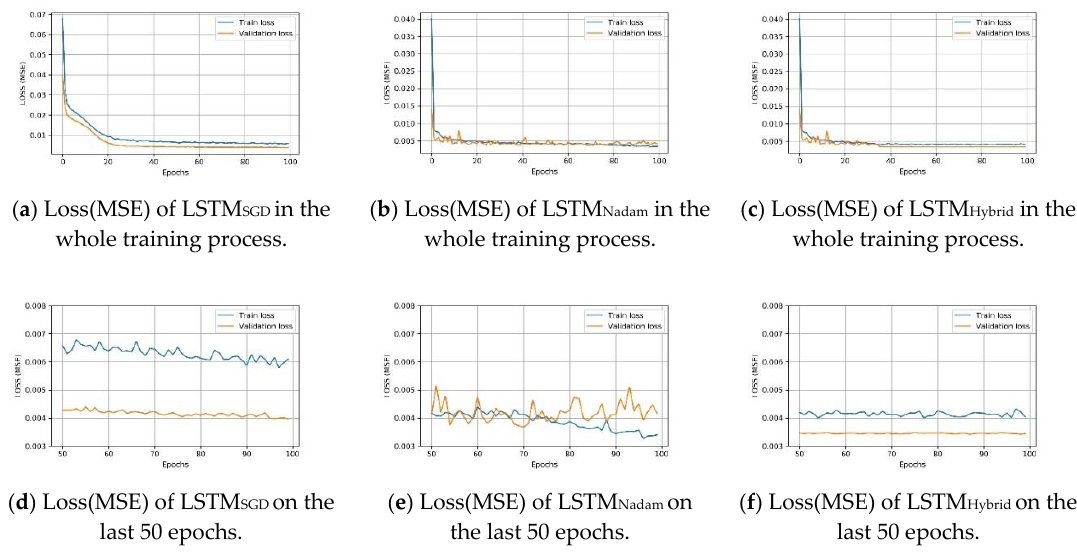
Figure 10. Convergence curves of the LSTM SGD , the LSTM Nadam and the LSTM Hybrid models with different learning rates on validation set.